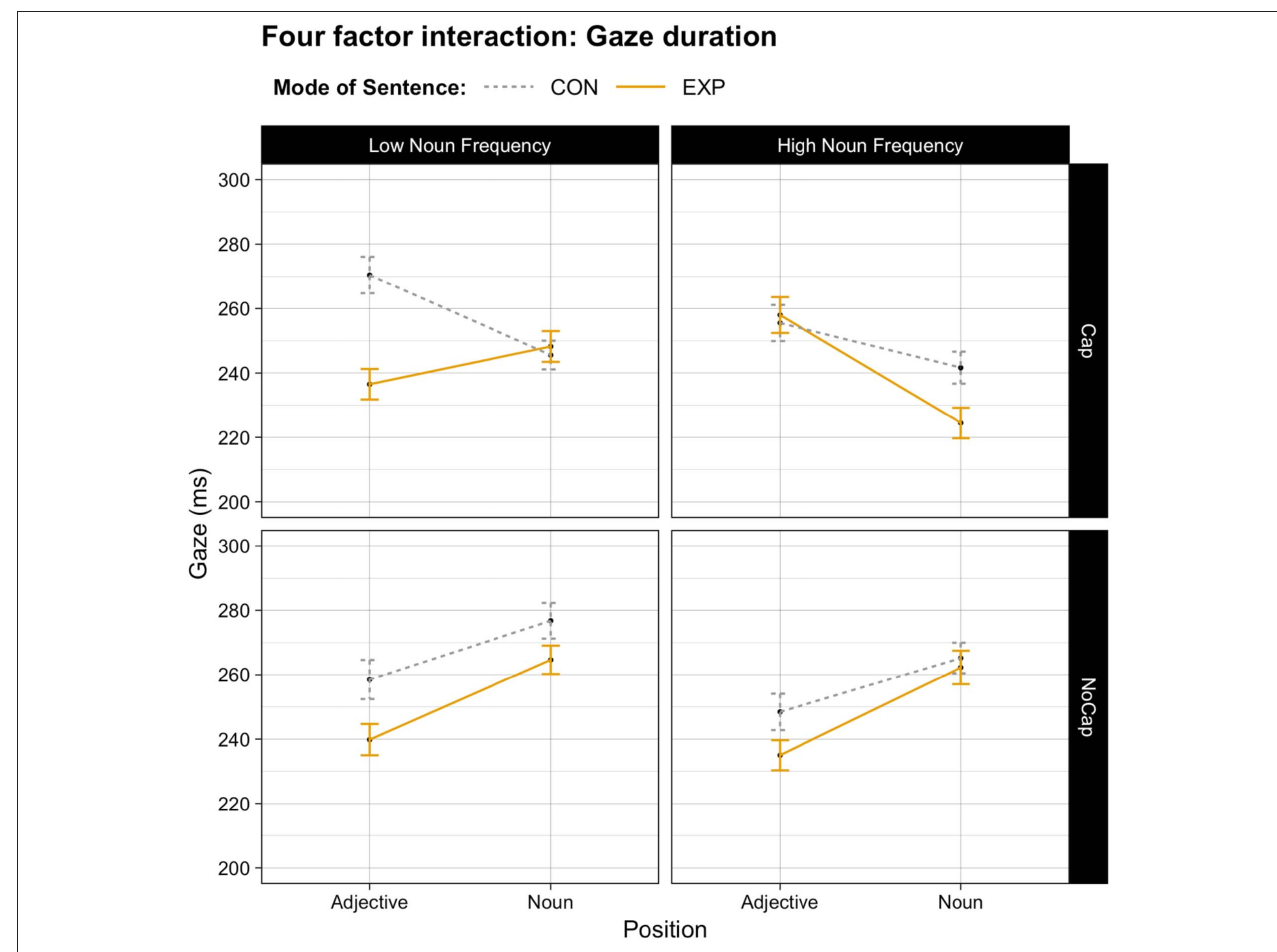
FIGURE 5 | Gaze duration on Adjective and Noun depending on the noun frequency. Estimated values of the four-way interactions of SPELLING (Cap vs. NoCap), SENTENCEMODE (EXP vs. CON), POSITION (Adjective vs. Noun) and FREQNOUN, i.e., the influence of the noun frequency on the fixation durations on the adjective and the noun themselves, divided into two groups: Adjective vs. Noun in Gaze duration (to the left); error bars represent the standard errors. Within both panels, “Low Noun Frequency” is shown to the left, “High Noun Frequency” to the right. Sentences following German standard orthography (Cap) are shown in the upper part of the graph, while the lower part represents sentences, in which the standard orthography is violated, i.e., noun with lowercase letter (NoCap). “Low” and “high” show the fixation duration depending on the level of noun frequency. The garden-path sentences (EXP, garden-path only in NoCap) are represented by solid yellow lines and the control sentences (CON) are represented by dotted gray